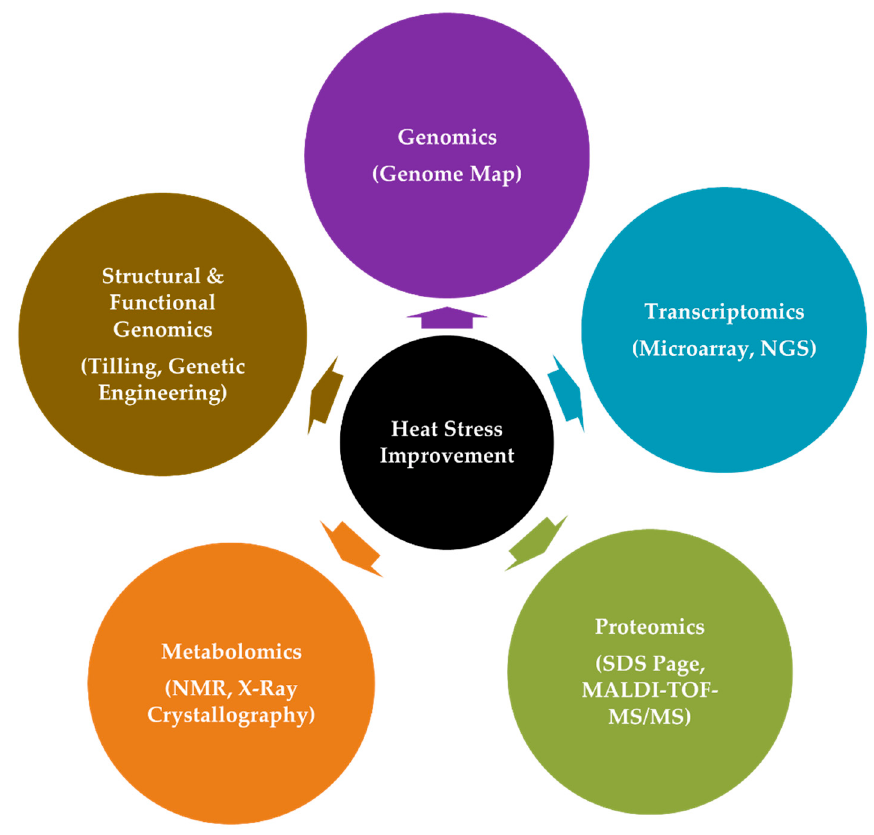
Figure 3. Different omics-based approaches for inculcating HS tolerance in